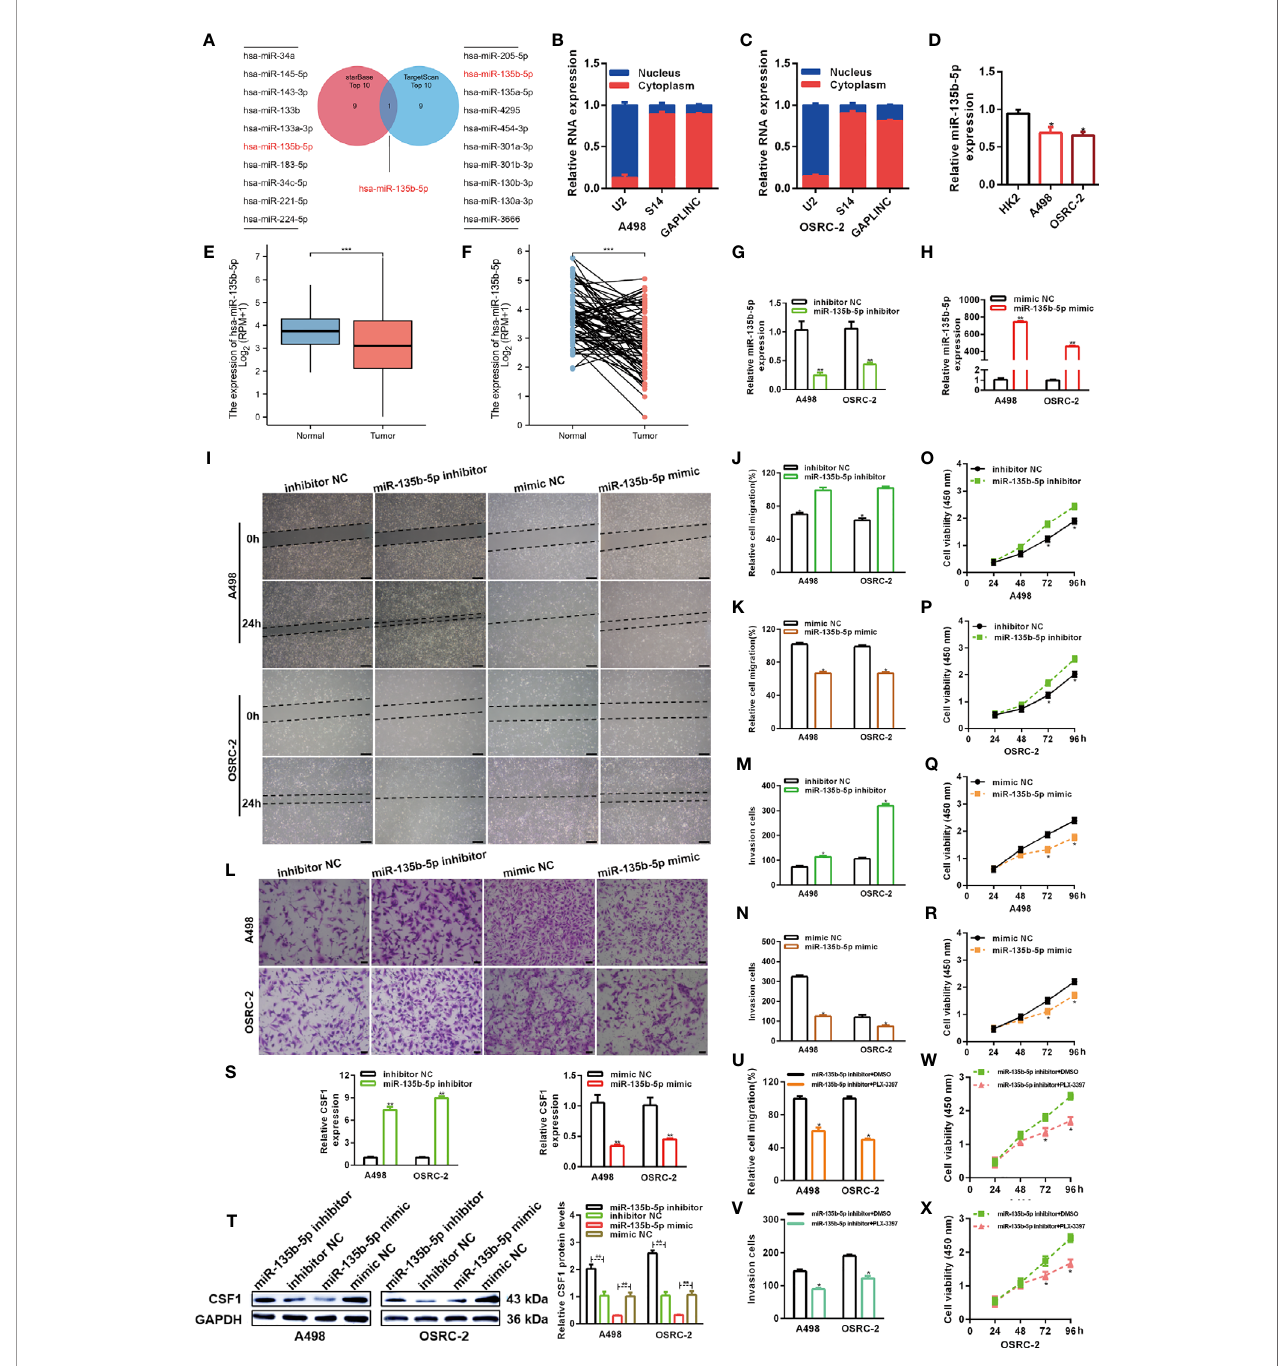
FIGURE 4 | MiR-135b-5p inhibits RCC cell proliferation and migration in vitro . (A) Schematic showing overlapping miRNAs predicted by the starBase and TargetScan databases to target GAPLINC and CSF1. (B, C) Relative level of GAPLINC in the nuclear and cytoplasmic fractions of A498 and OSRC-2 cells. (D) Relative expression of miR-135b-5p in A498 and OSRC-2 cells detected using RT-qPCR. TCGA analysis of the expression levels of GAPLINC in paired (E) and unpaired (F) RCC tissues. MiR- 135b-5p expression levels following transfection of A498 and OSRC-2 cells with miRNA inhibitors (G) or miRNA mimics (H) . The migration capacities were measured by wound closure (I – K) (scale bars = 200 m m) and transwell (L – N) (scale bars = 50 m m) assays after the cells were transfected with miR-135b-5p inhibitors or mimics. The effect of miR-135b-5p inhibitors (O, P) or mimics (Q, R) on A498 and OSRC-2 cell proliferation was detected by CCK-8 assay. (S) RT-qPCR was performed to detect CSF1 expression after transfection with miR-135b-5p inhibitors and mimics. (T) The protein expression level of CSF1 was detected using Western blotting following RCC cell transfection with miR-135b-5p inhibitors or mimics. The effect of PLX-3379 on the migration and proliferation of RCC cells transfected with miR-135b-5p inhibitor was detected by wound closure (U) , Transwell (V) and CCK-8 (W, X) assays. *p < 0.05; **p < 0.01; ***p <